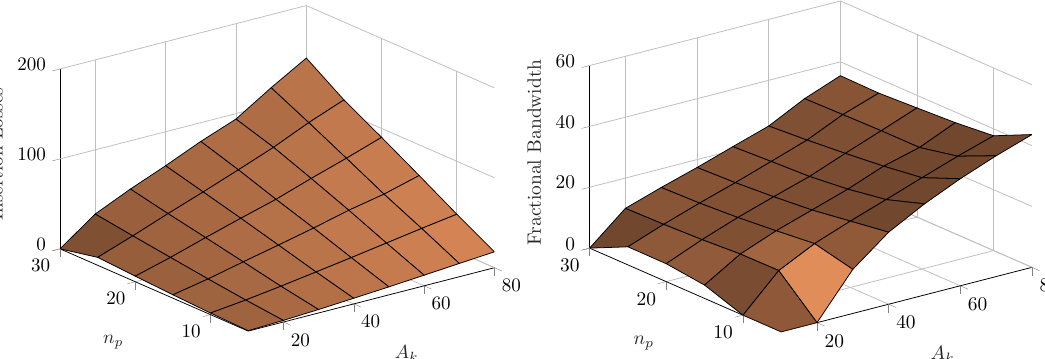
Figure 7. Influence of the design parameters ( A k and n p ) on the stop band response of the ESICL filter (insertion losses and fractional